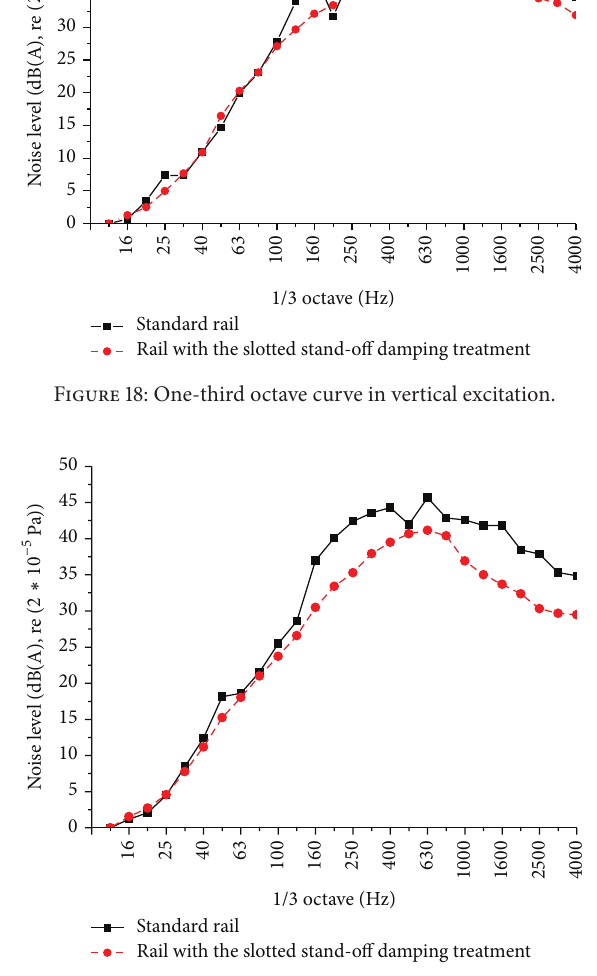
waist and rail foot, arranged on both sides of the rail in the zone under the rail